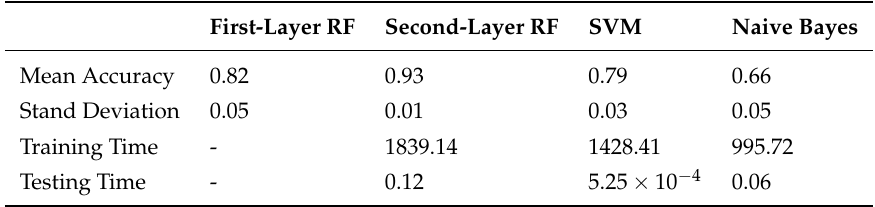
Table 5. Comparison of different